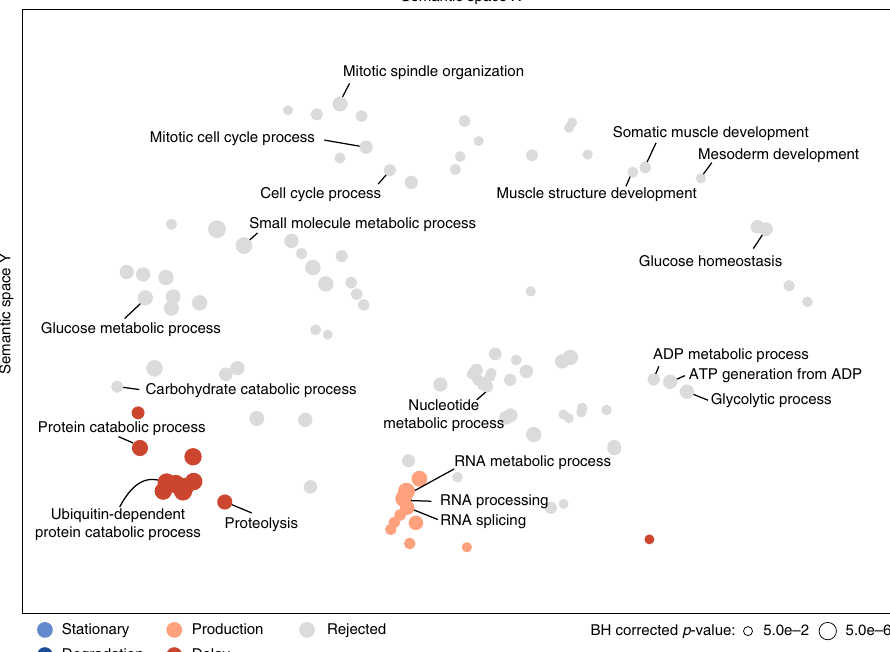
Fig. 5 Protein classes are enriched for speci fi c biological functions. Distinct GO terms are signi fi cantly (hypergeometric test, BH corrected p value < 0.05) overrepresented in the production and delay category as well as for the rejected class (indicated by color). GO terms were arranged according to their semantic similarity and a 2D projection was generated via multidimensional scaling. Each circle represents a single GO term and the size of each circle is proportional to the corrected p value (see